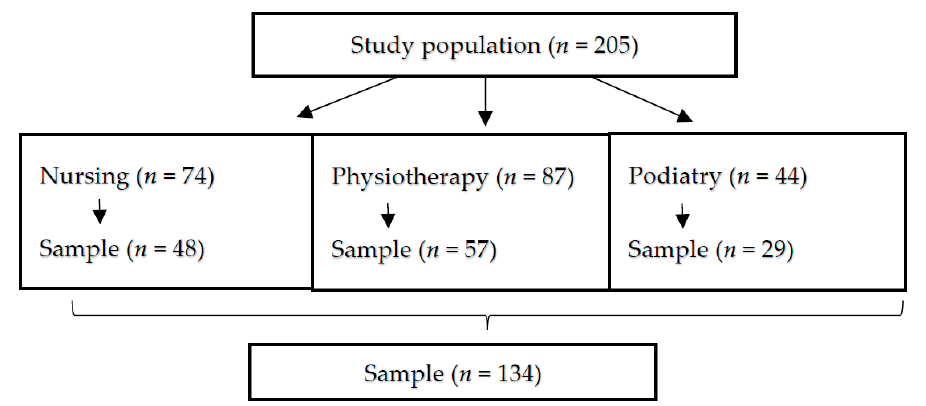
Figure 1. Study participants.